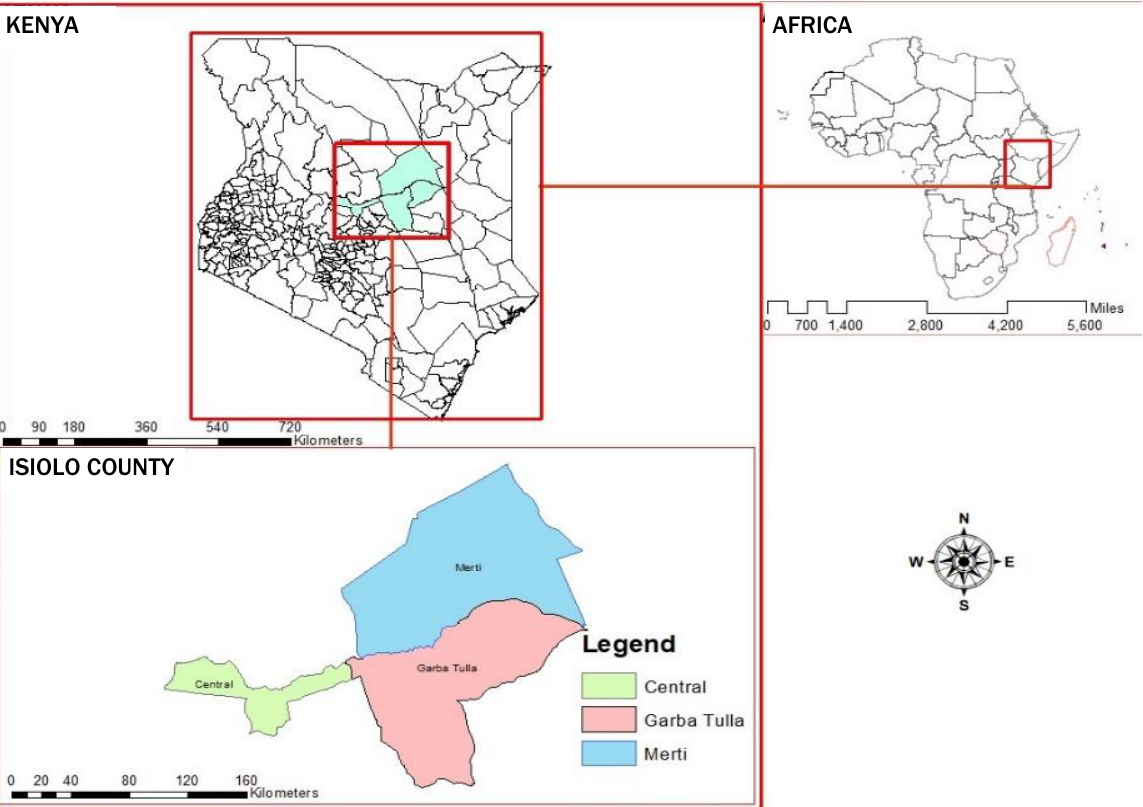
Figure 1. The Location of the Study Area in